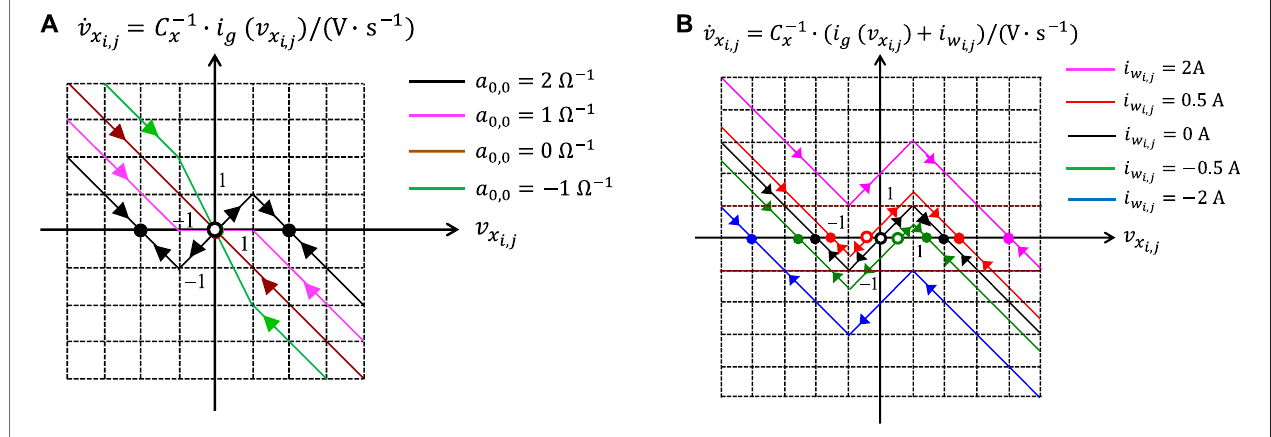
FIGURE3|(A) FamilyofInternalDPCharacteristics,whichaCNNcelladmitsforeachvalueoftheself-feedbacksynapticweight a 0 , 0 intheset {− 1 , 0 , 1 , 2 } Ω − 1 . (B) Family of Shifted DP Characteristics, which a CNN cell admits for a 0 , 0 (cid:1) 2 Ω − 1 for each value of the offset current i w parameter values for the derivation of these viewgraphs is provided here: C x (cid:1) 1F, R x (cid:1) 1 Ω , g lin · R y (cid:1) 1, and v sat (cid:1) 1